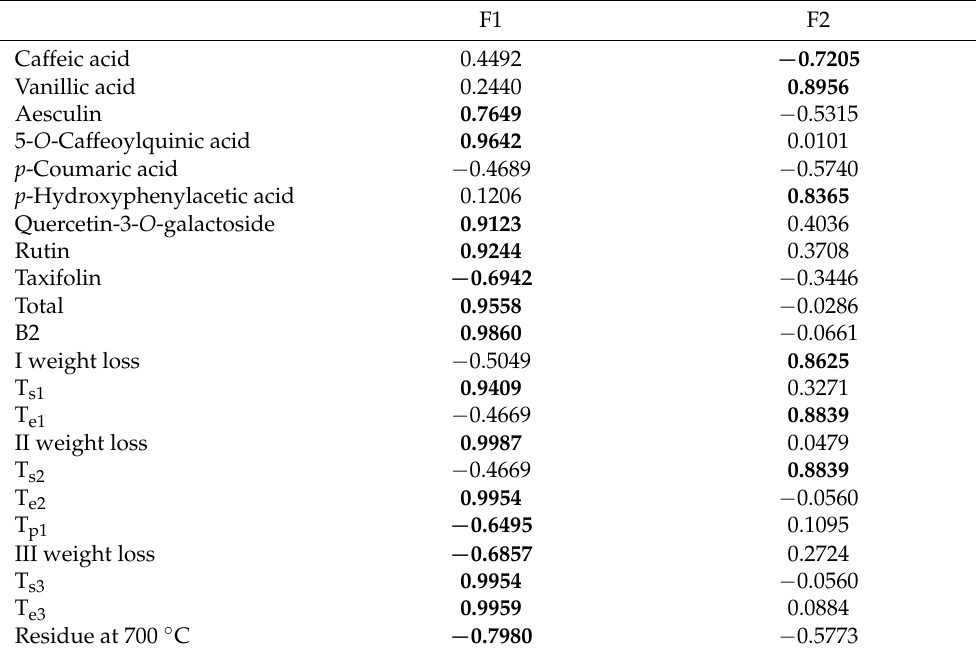
Table 4. Factor loadings of principal component (PC) 1 and 2, obtained by principal component analysis (PCA) of phenolic profile, vitamin content, and thermal characteristics of different stinging nettle leaves’ extracts. Values in bold are factor loadings whose the absolute value is >0.6.